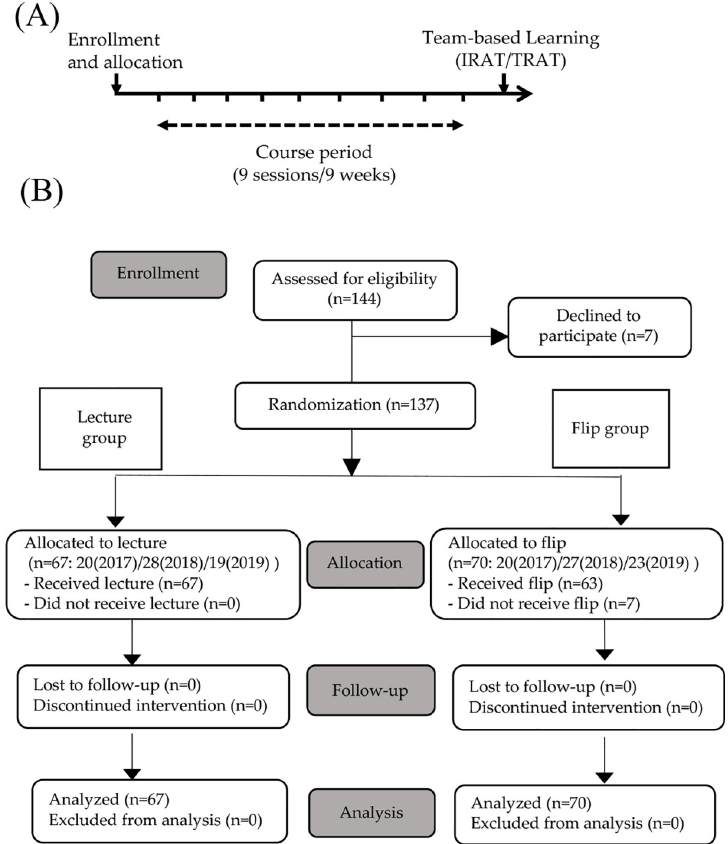
Fig 1. Timeline and participants flow. (A) Timeline of this study. IRAT, individual readiness assurance test; TRAT, team readiness assurance test. (B) Participants flow until